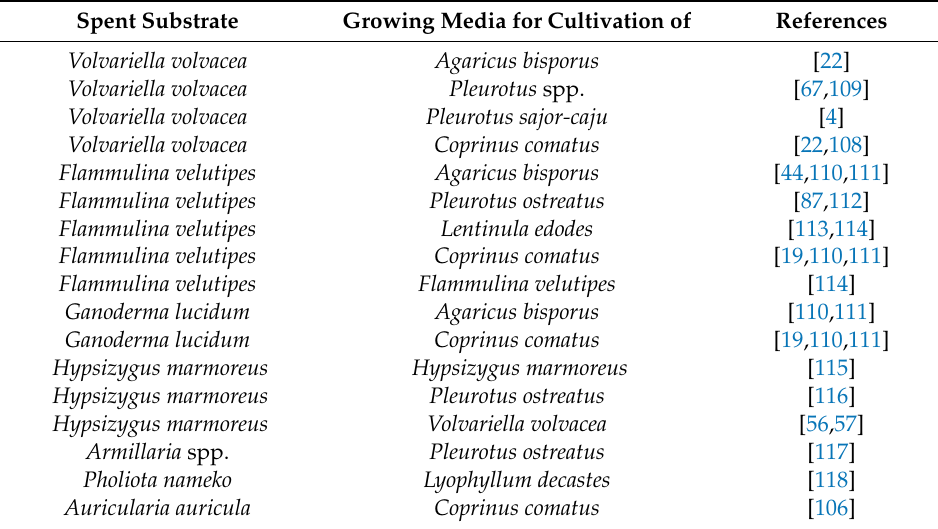
Table 5. Reuse of SMS of other mushroom species in new substrate